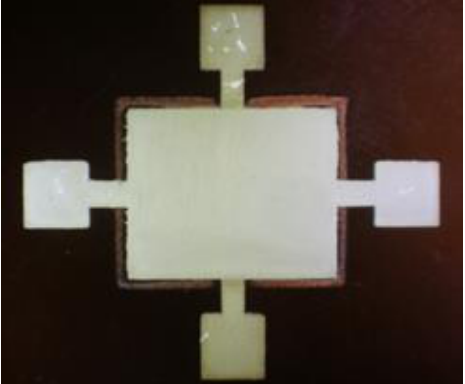
Figure 6. Photographic view of the multilayer test device printed on Kapton, which allowed the characterization of the dielectric constant of the UV insulating ink and the breakdown voltage.